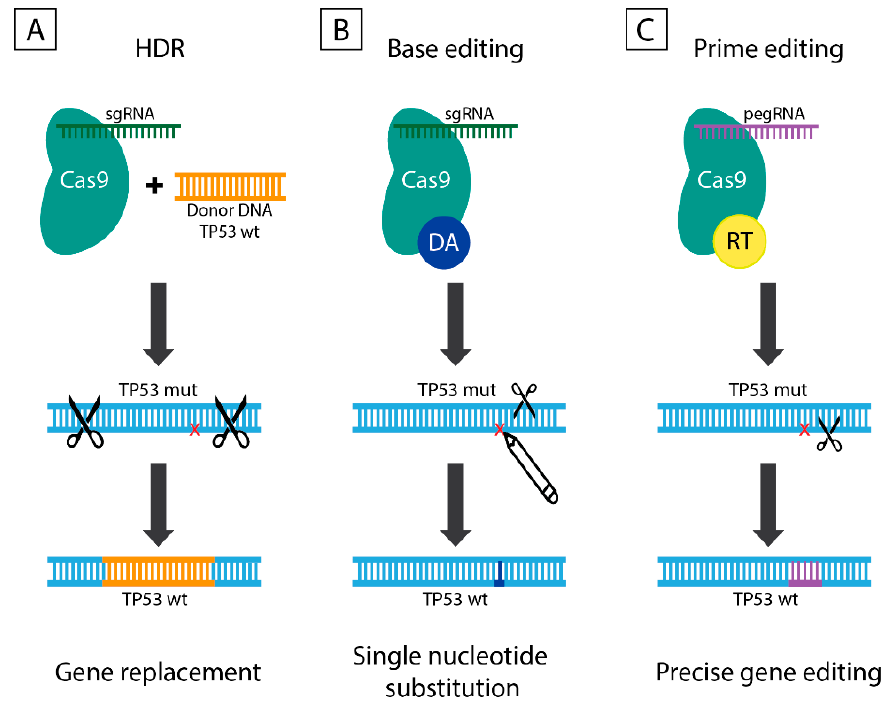
Figure 3. The diverse approaches for TP53 gene editing: DSB-mediated gene replacement by a normal